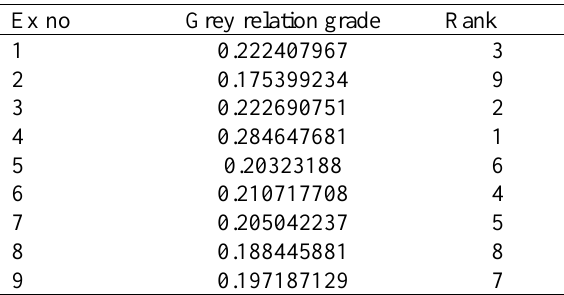
Table 9. Grey relational grade and its